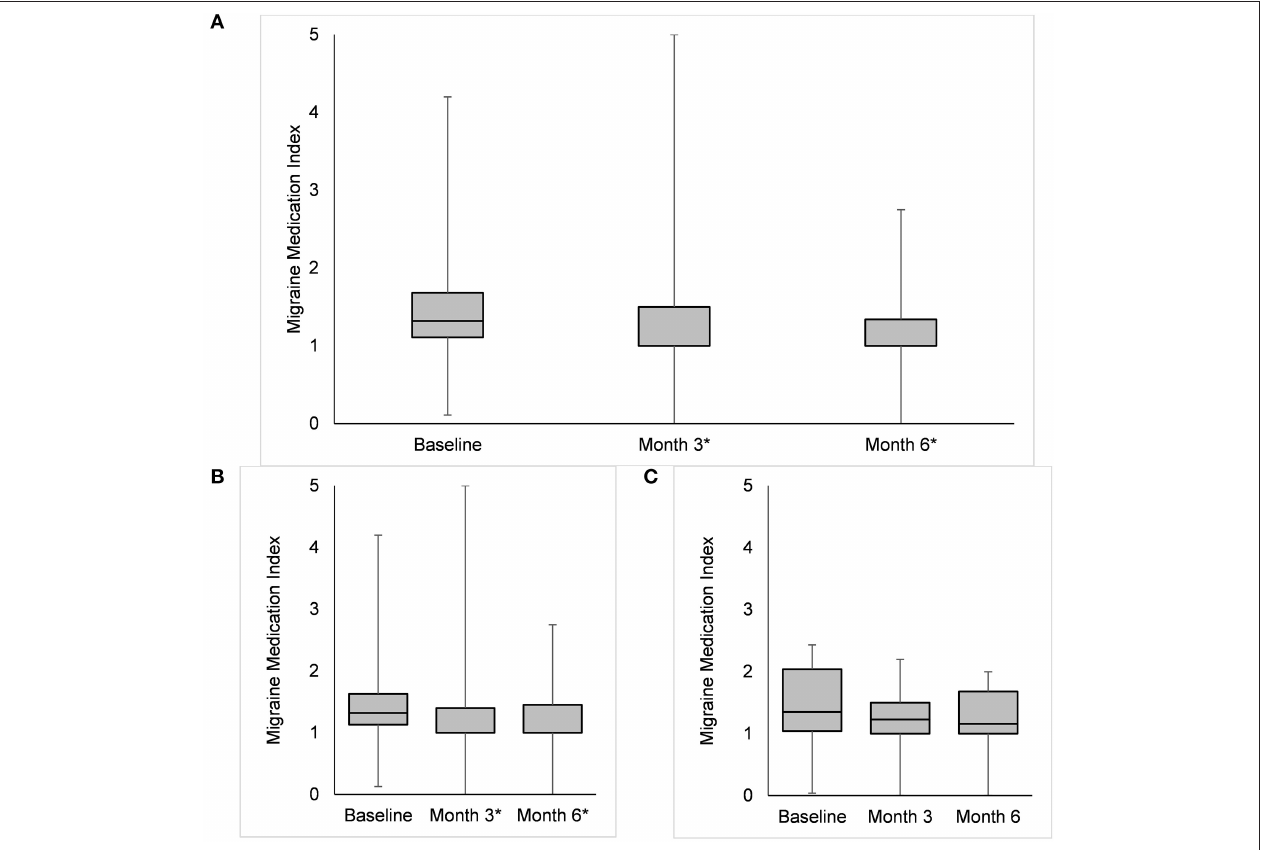
FIGURE 2 | Box plots representing the Migraine Medication Index (i.e., the ratio between monthly drug intake and monthly migraine days) in the overall group (A) , in patients reporting a ≥ 50% reduction in monthly migraine days (B) , and in those reporting a < 50% reduction in monthly migraine days (C) compared with baseline. The asterisks highlight significant ( p < 0.05) differences.